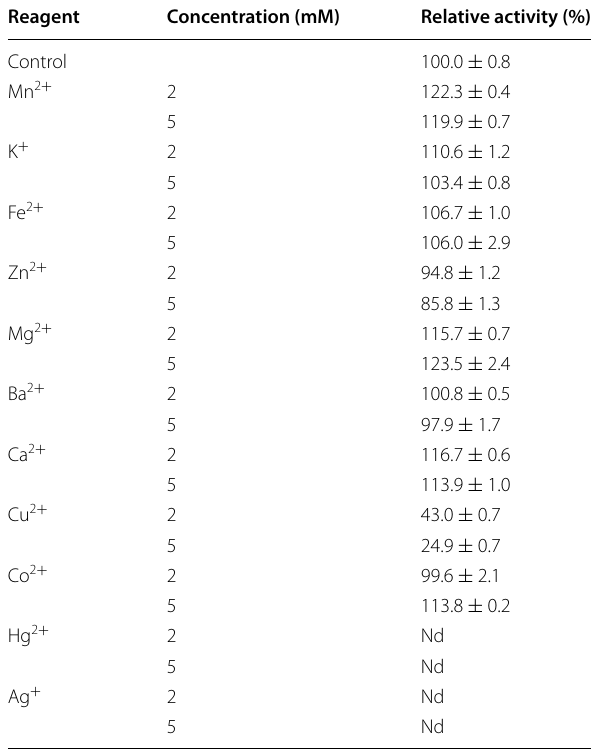
Table 1 Effects of metal ions on the enzymatic activity of the recombinant